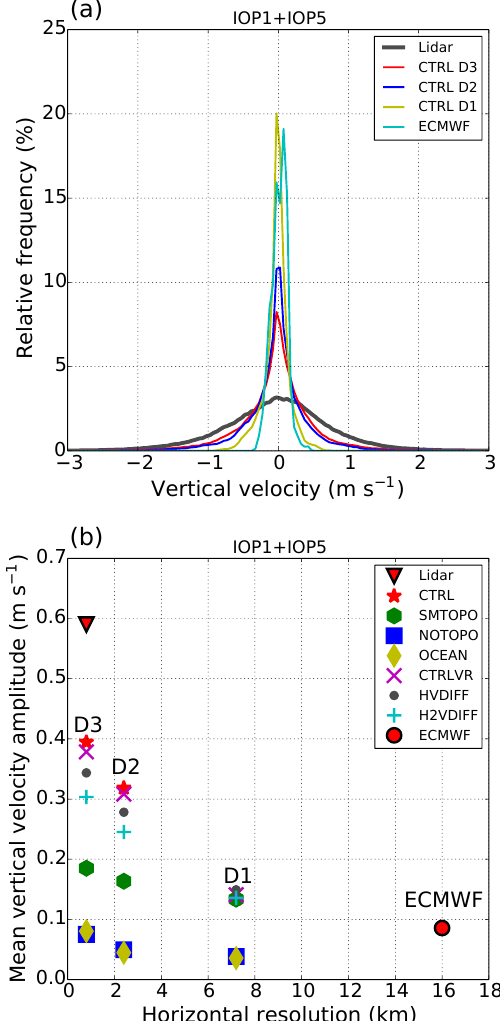
Figure 17. Lidar and model vertical velocity distribution (a) and mean vertical velocity amplitude depending on horizontal model grid resolution (b) for all lidar nadir-pointing flight legs during both IOP1 and IOP5 (cf. Fig.